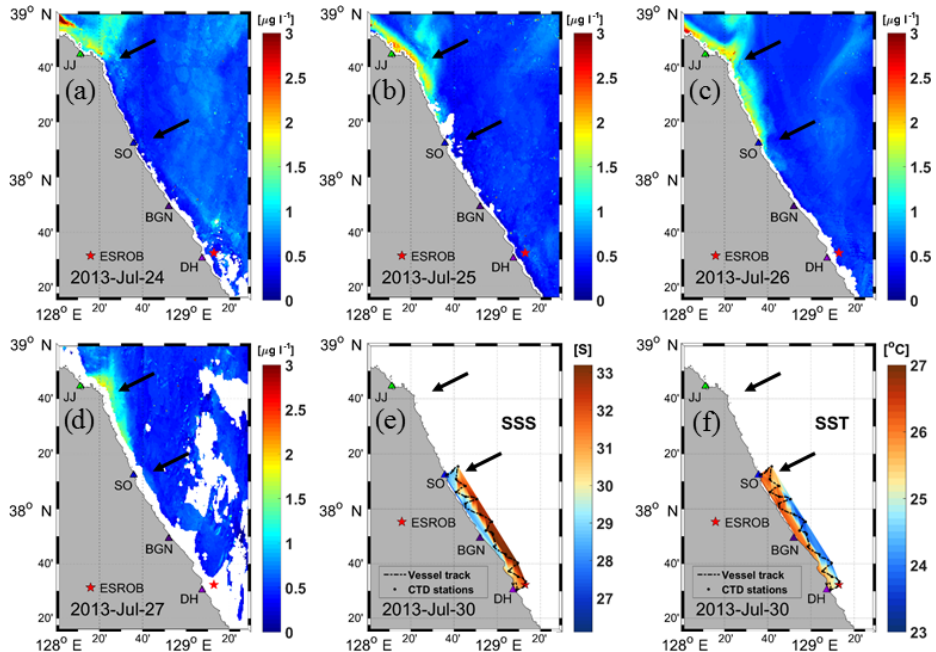
Figure 8. (a) – (d) Daily series of GOCI indicating surface chlorophyll a distributions from 24 to 27 July 2013. Surface distributions of in situ (e) salinity and (f) temperature (dashed lines: ship tracks; dots: CTD stations) in 30 July 2013 a couple of days after heavy rainfall in the region. Two black arrows in each panel point to the same locations in the vicinity of JJ (JangJun) and SO